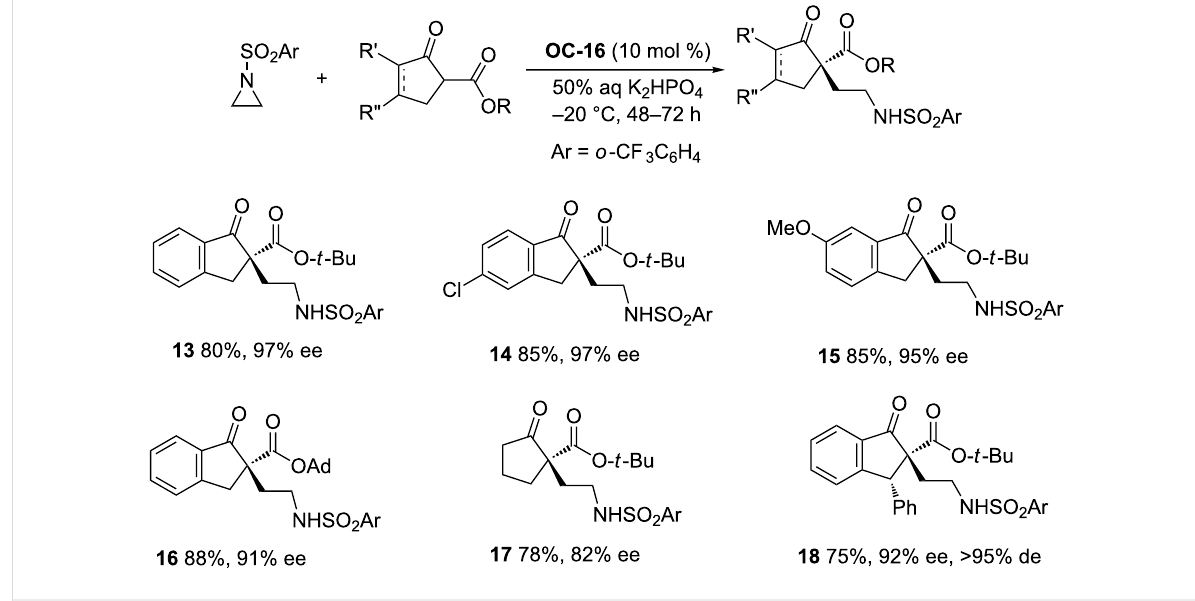
Scheme 2: The enantioselective ring-opening of aziridines in the presence of OC-16 .